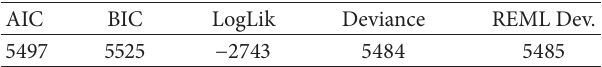
Table 9: Model selection of